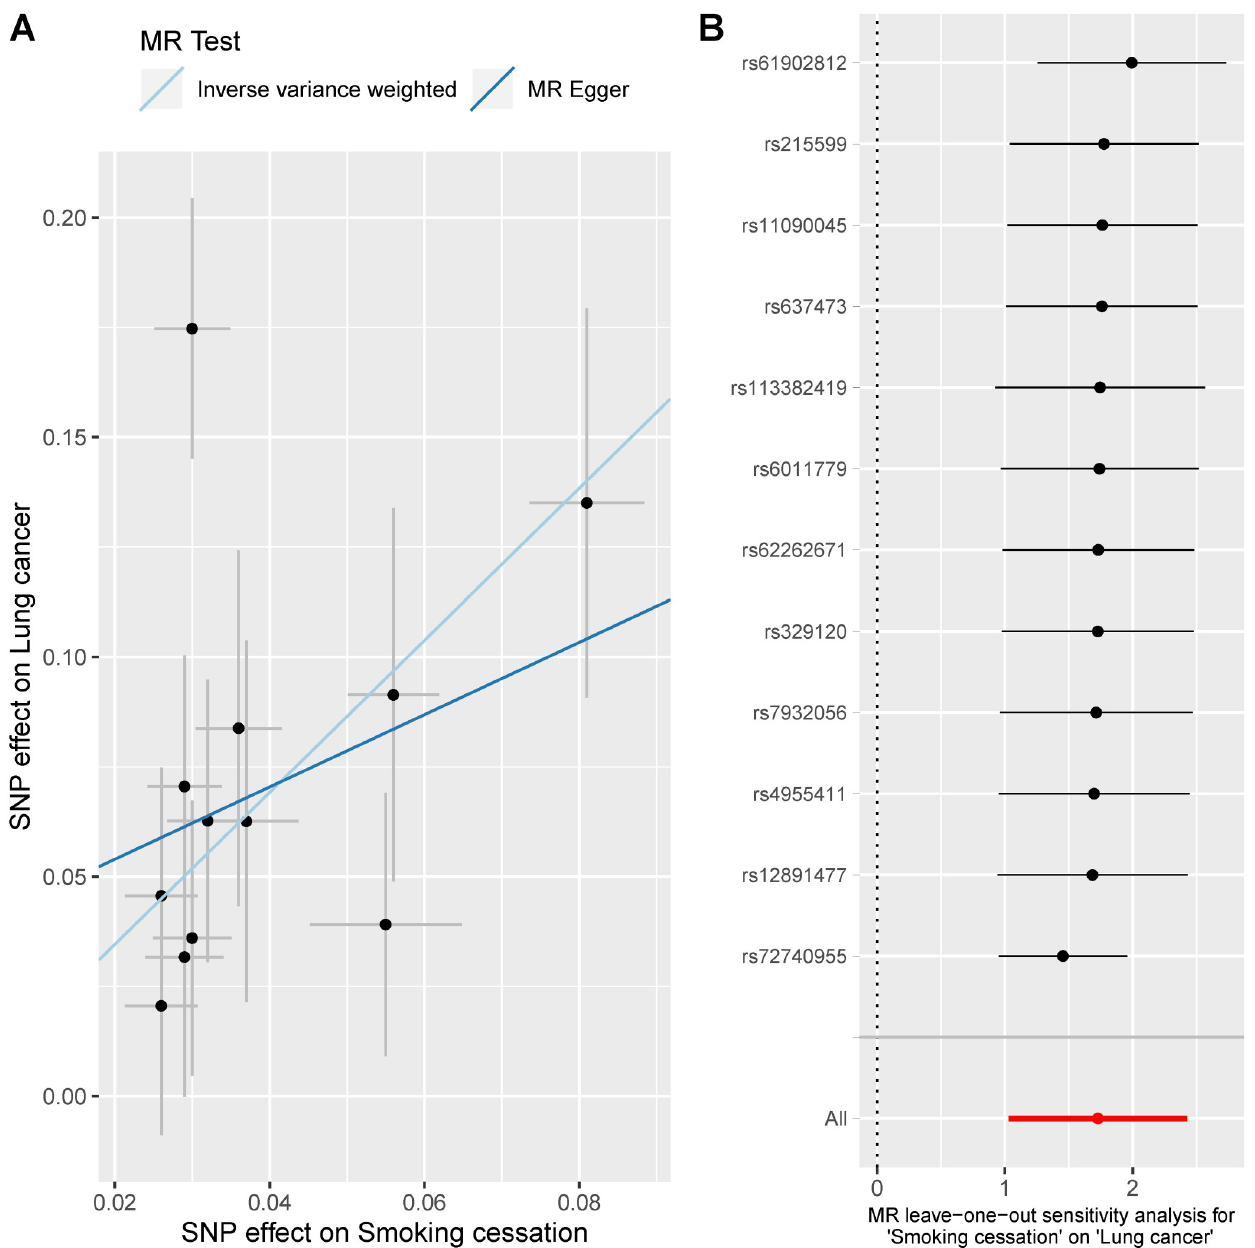
Fig 5. MR analysis of the effect of smoking cessation on lung cancer. Fig 5A is the scatter plot of the MR result. Fig 5B is the forest plot of the leave-one-out sensitivity result.